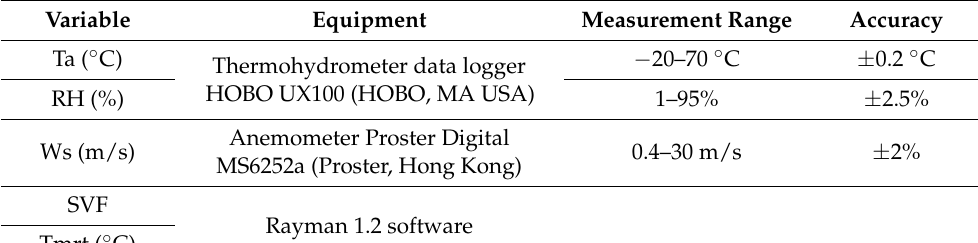
Table 1. Environmental measuring equipment